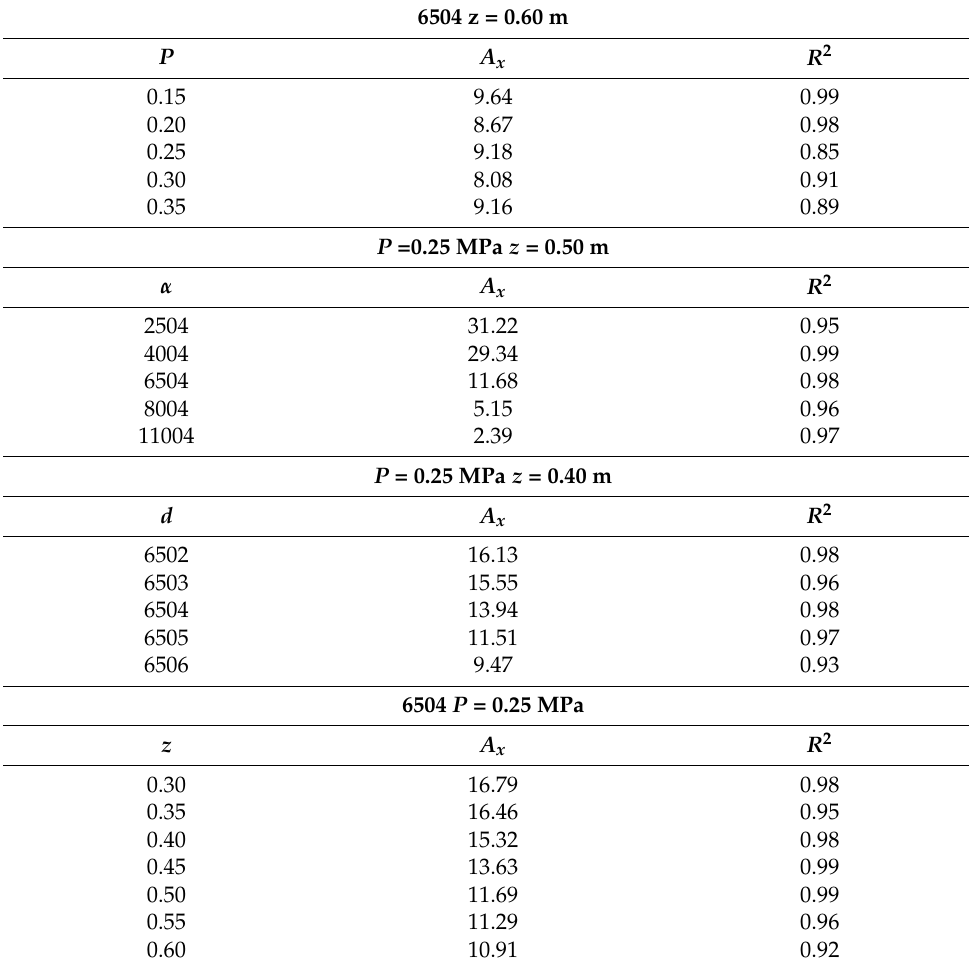
Table 2. A x and the fitting degrees for different spray